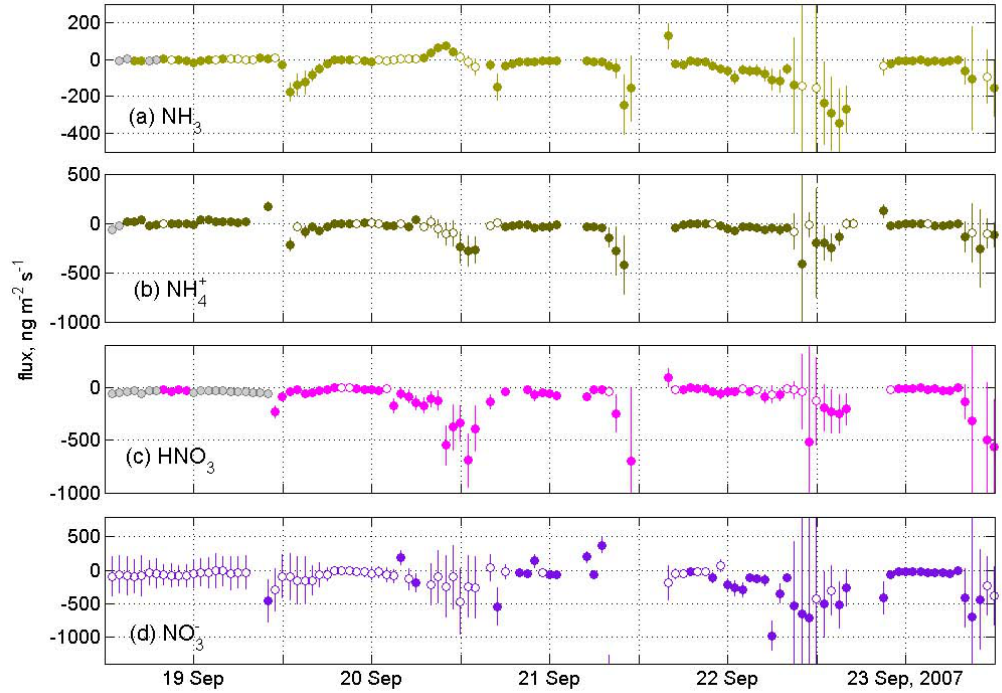
Fig. 13. Fluxes of (a) NH 3 , (b) particulate NH + , (c) HNO 3 , and (d) particulate NO − during EGER. Error bars are derived from both, σ vtr 4 3 and σ 1C . Hollow symbols denote flux values that are derived from 1C that are insignificantly different from zero (Sect. 4.2). Grey circles denote flux values calculated with one or both concentrations below the